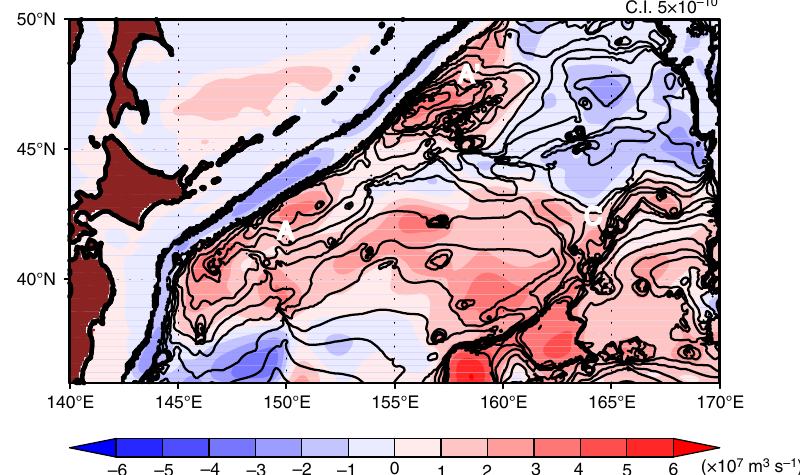
Fig. 5 Barotropic ambient potential vorticity and barotropic streamfunction. Contour lines denote barotropic ambient potential vorticity f / H (contour interval: 5×10 − 10 s − 1 m − 1 ) and shade denotes streamfunction derived from the JCOPE2 reanalysis. Closed contours of f / H are present over the rises A , A ′ , and